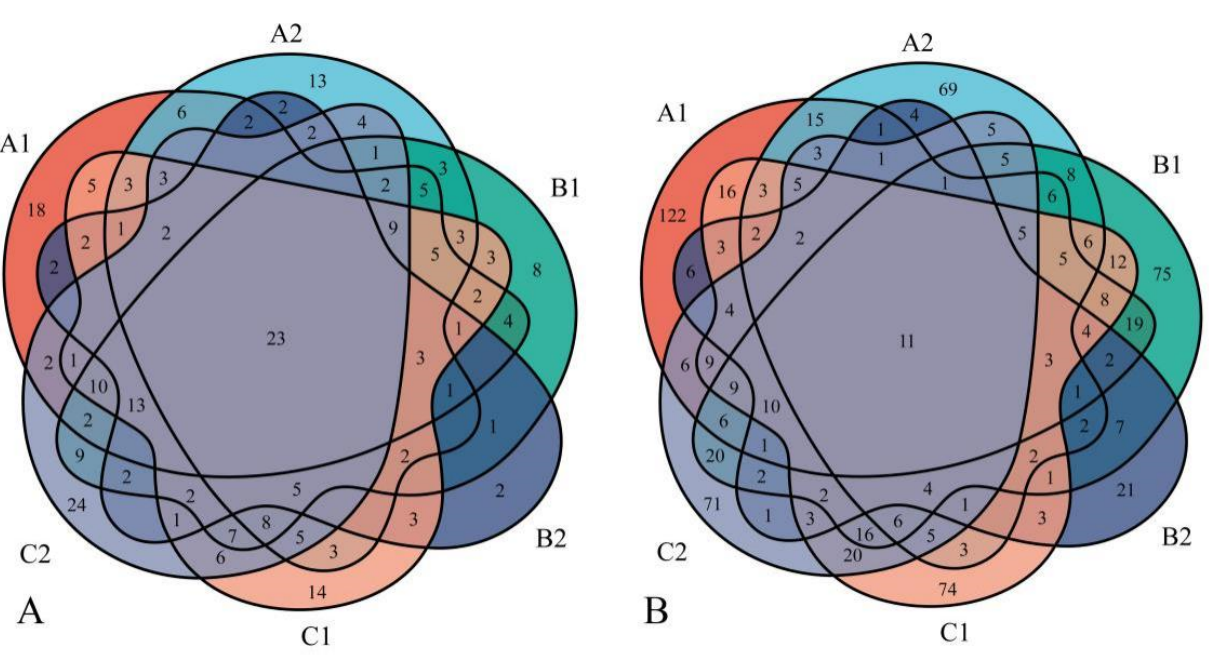
Figure 5. The co-occurring genera and species were analyzed in six different investigation sites in Jilin Province. ( A ) Co-occurring genera analysis in six investigation sites; 23 genera co-occur in six investigation sites; site B2 has the fewest endemic genera and C2 has the most. ( B ) Co-occurring species analysis in six investigation sites; 11 species occur in all six investigation sites; site A1 has the most endemic species, while site B2 has the fewest. A1: Quanshuidong Forest Farm; A2: Lushuihe National Forest Park; B1: Shengli River Forest Farm; B2: Longwan National Forest Park; C1: Zuojia Region; C2: Jingyuetan National Forest Park.